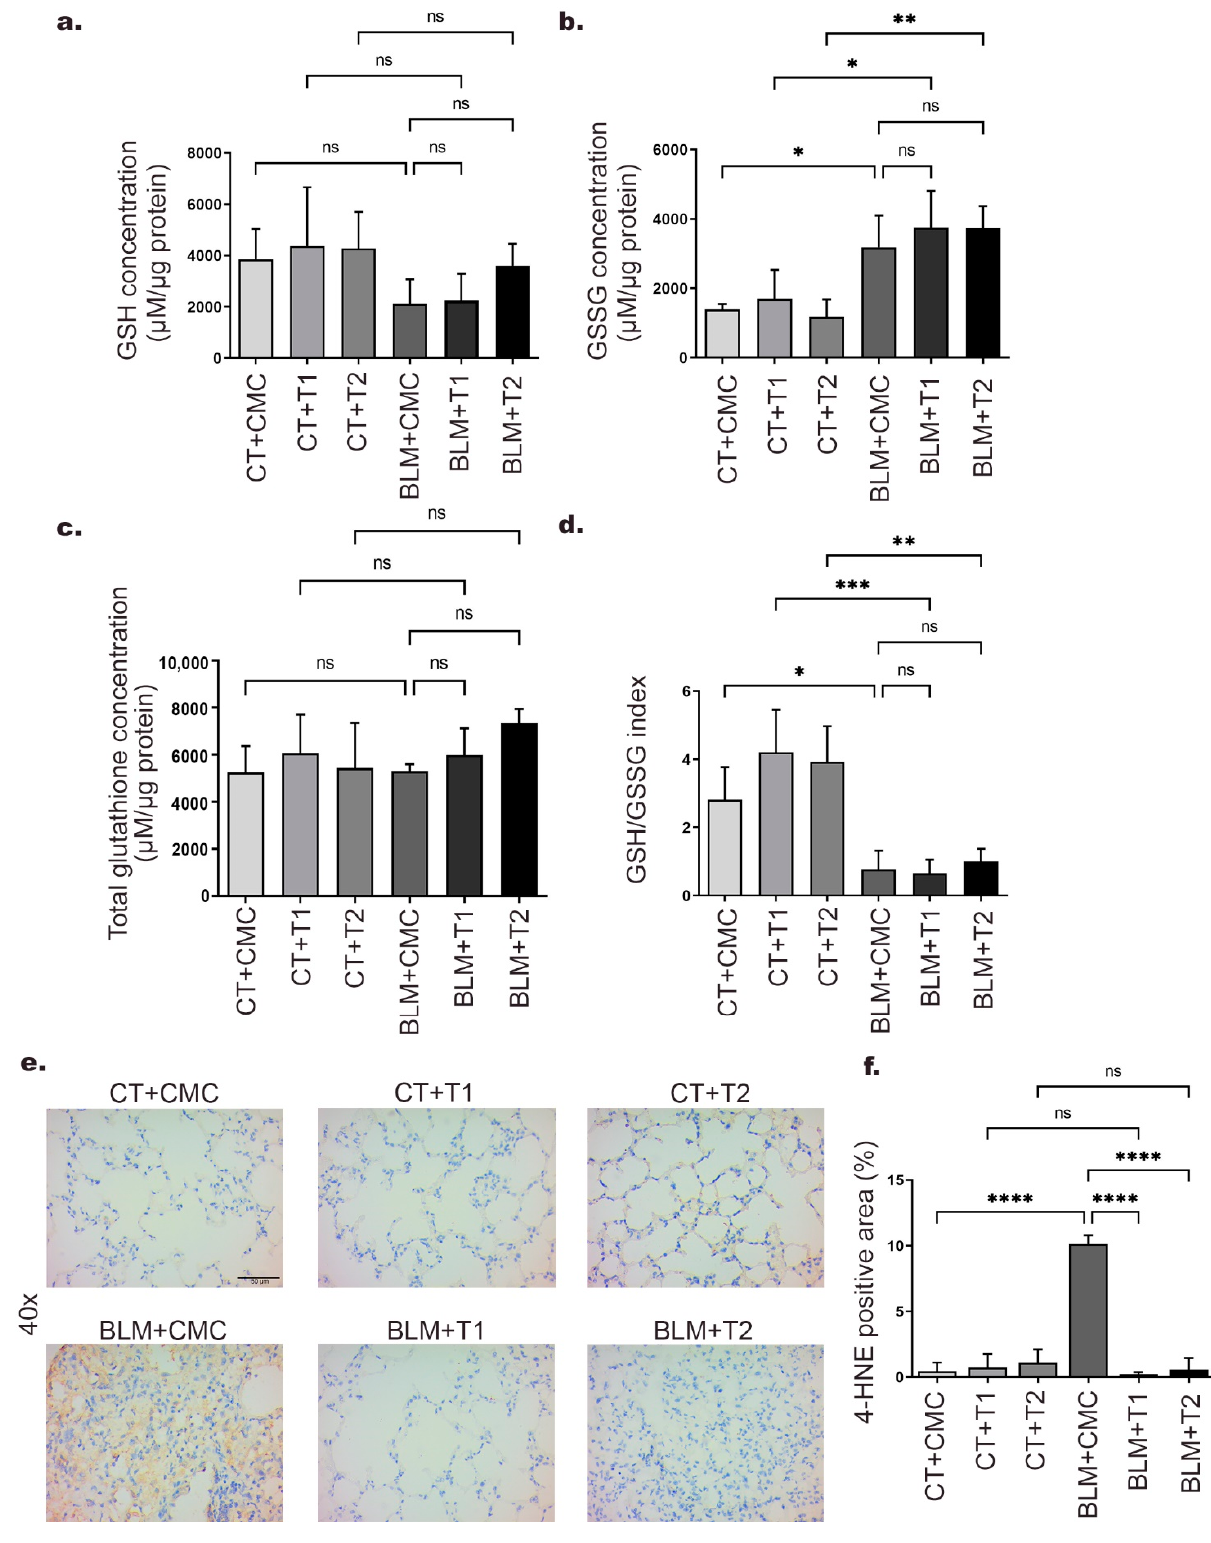
Figure 5. 3 ′ 5-DMBA can exert pro-oxidant effects without favoring increased lipid peroxidation. Mice in BLM groups were instilled with an osmotic minipump loaded with BLM 100 U/kg. Mice in control groups (CT) have a sham instillation. On day 14, mice received either 3 ′ 5-DMBA or its vehicle intragastrically until they were euthanized on day 28. Oxidative stress parameters, including ( a ) GSH concentration, ( b ) GSSG concentration, ( c ) total glutathione concentration, and ( d ) GSH/GSSG ratios, were determined from lung tissue by colorimetric assays. ( e ) Immunohistochemical staining for 4-HNE in lung tissue sections. Positive staining is shown in brown. ( f ) Bar graph showing